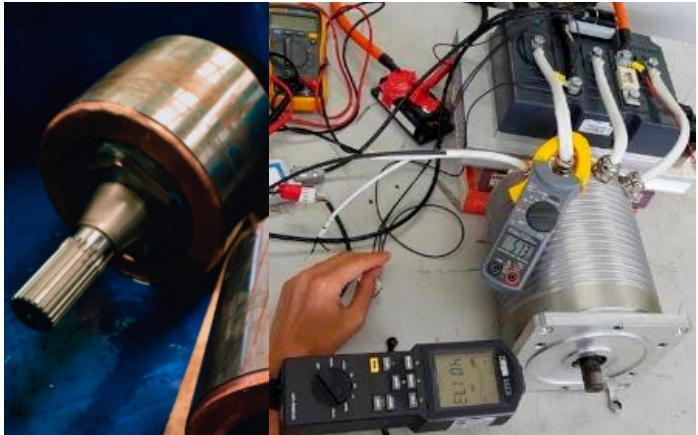
Figure 8. Thermal simulation for S3 30% duty cycle.